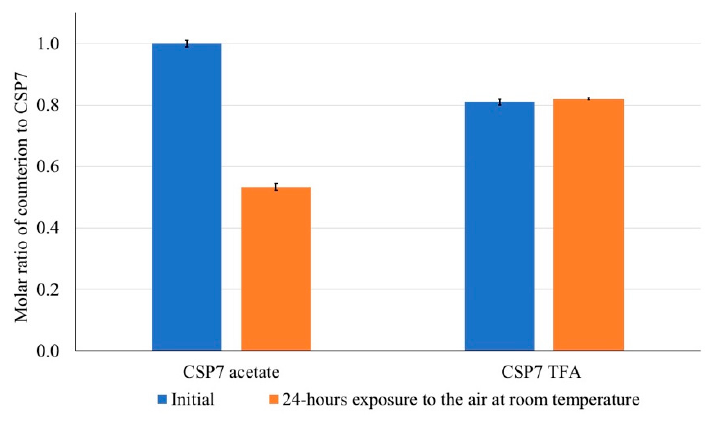
Figure 4. Molar ratio of acetate to CSP7 after exposure to air at room temperature.